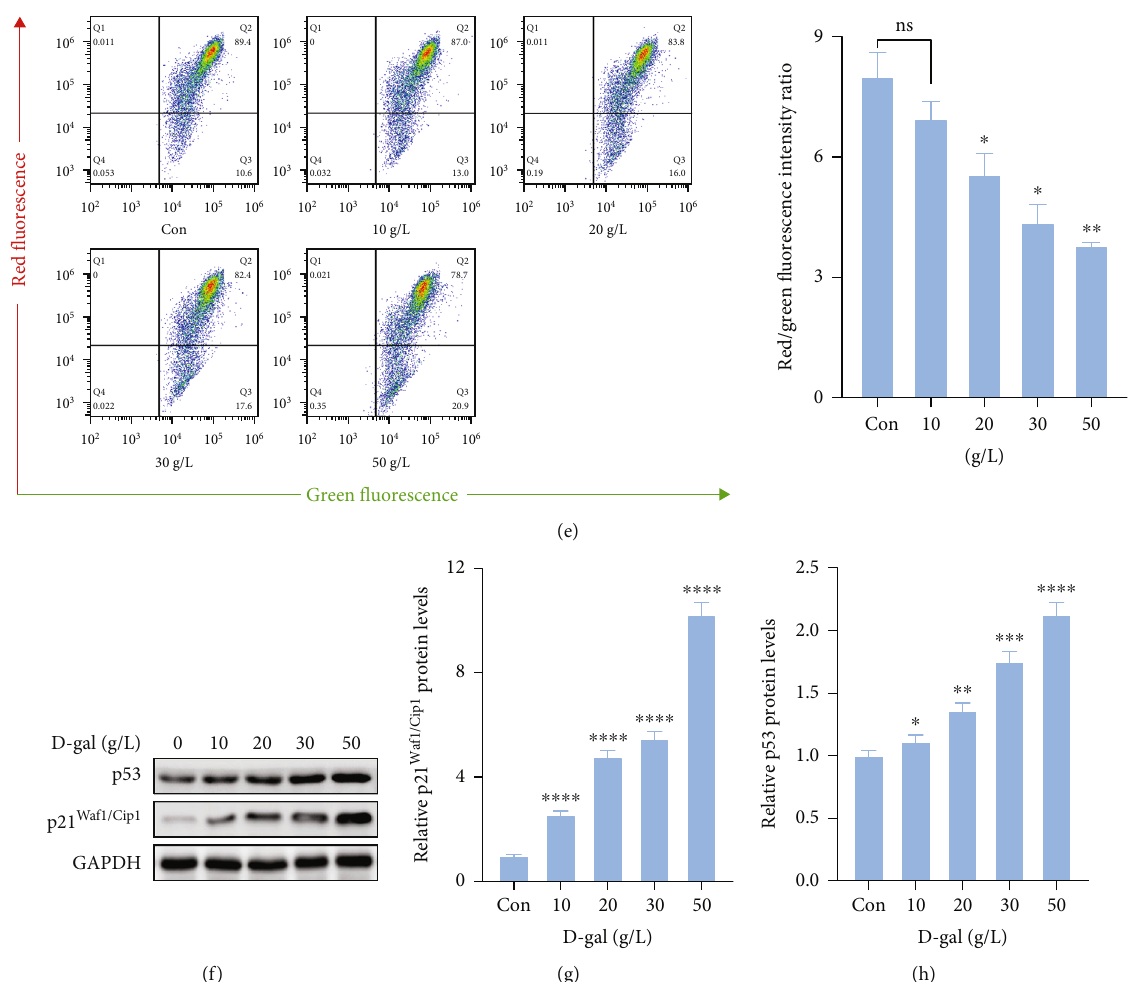
Figure 1: The cytotoxicity of D-gal on hBMSCs and e ff ects of di ff erent concentrations D-gal on hBMSC senescence. (a) The cell viability of hBMSCs was assessed by CCK8 assay following treatment with di ff erent concentrations of D-gal (0-100g/L) for 24 h. (b) Quanti fi cation of intracellular ROS levels by fl ow cytometry. (c) Representative images of fl ow cytometry of intracellular ROS levels. (d) Representative images of SA- β -Gal-positive hBMSCs, scale bar, 100 μ m. (e) Quanti fi cation of MMP by fl ow cytometry. (f – h) The expressions of p21 Waf1/Cip1 and p53 proteins were detected by western blot analysis. GAPDH was used as a control. n = 2 − 3 for each group. Data shown are mean ± SEM . Two-tailed t test. ∗ p < 0 : 05 , ∗∗ p < 0 : 01 , ∗∗∗ p < 0 : 001 , and ∗∗∗∗ p < 0 : 0001 versus the control group; ns: not signi fi